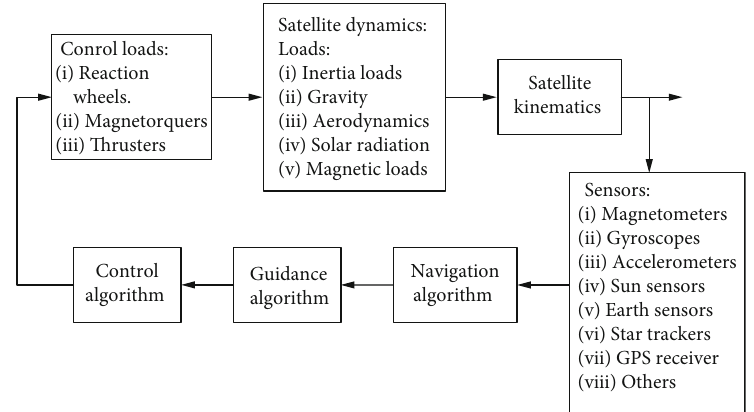
Figure 1: Satellite simulation model architecture.